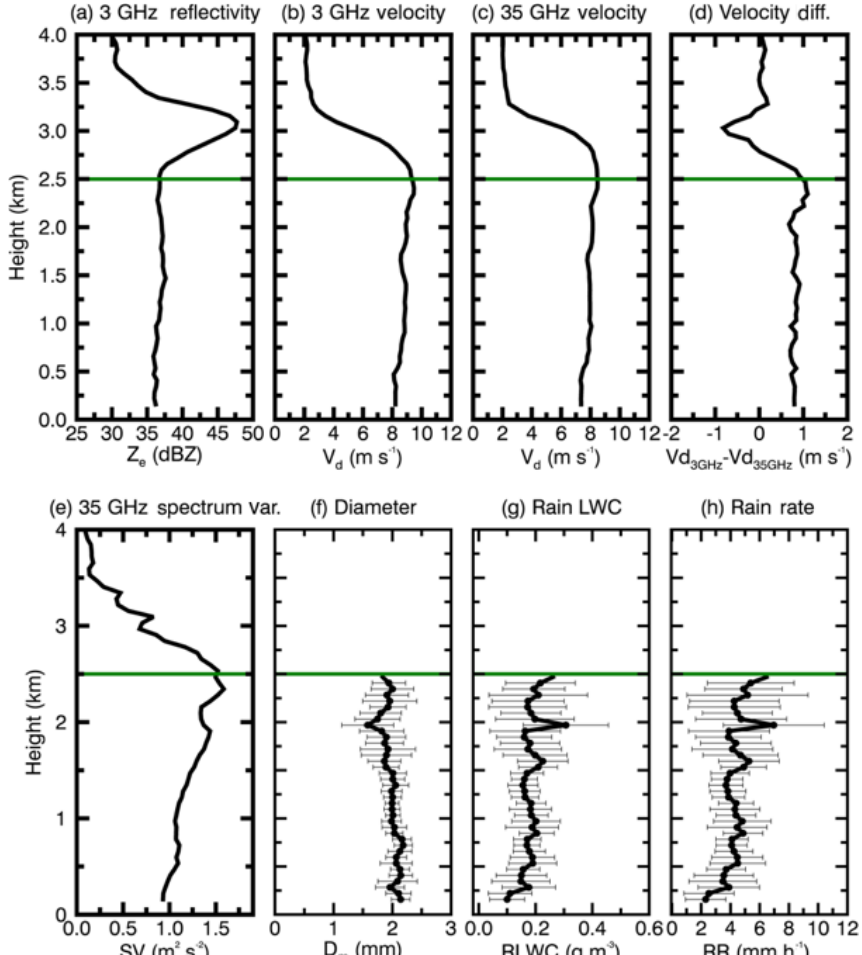
Figure 3. An example of illustrating the Doppler velocity difference (DVD) retrieval algorithm at 13:40UTC on 20 May 2011. The inputs of the DVD retrieval algorithm are (a) the 3GHz vertical pointing radar reflectivity factor ( Z e ), (b) the 3GHz radar Doppler velocities ( V d ), (c) the 35GHz radar Doppler velocities ( V d ), and (e) the 35GHz radar spectrum variance (SV). The Doppler velocity difference between 3 and 35GHz is shown in (d) . The outputs of the DVD retrieval algorithm are (f) mass-weighted mean diameter D m , (g) rain liquid water content (RLWC), and (h) rain rate (RR). Retrieval uncertainties are shown as horizontal thin black